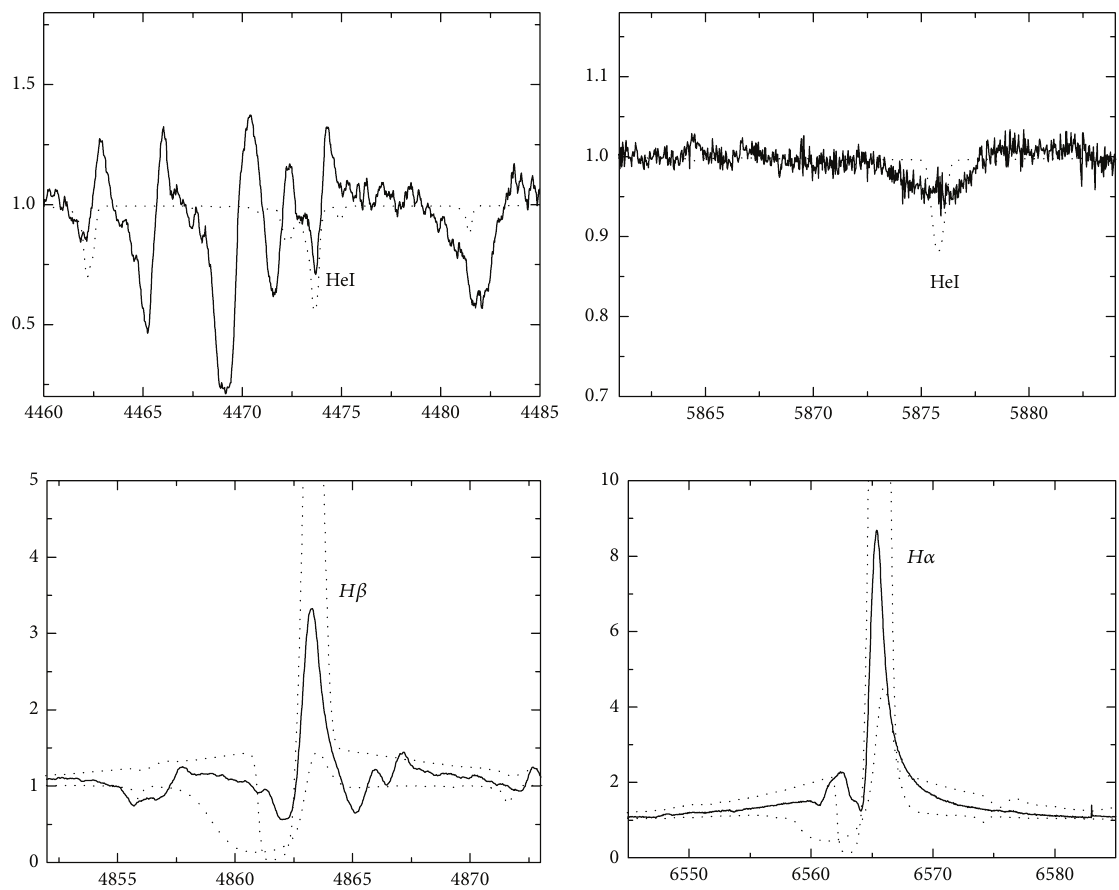
Figure 6: Modeling of selected optical He I lines at 4471 and 5876 ˚A (upper row) and the 𝐻𝛼 and 𝐻𝛽 lines (bottom row) for MWC 930. Parts of our CFHT spectrum taken on 2012 June 29 are shown by solid lines, while parts of the model spectra are shown by dotted lines. ̇𝑀 = 3 10 −5 M ⊙ yr −1 is shown for the He I lines. Two model spectra with mass loss rates of One model spectrum with a mass loss rate of ̇𝑀 = 3 10 −5 ̇𝑀 = 5.6 10 −5 M ⊙ yr −1 (with a weaker line emission) and M ⊙ yr −1 are shown for the Balmer lines. The intensity and wavelengths are in the same units as in Figure